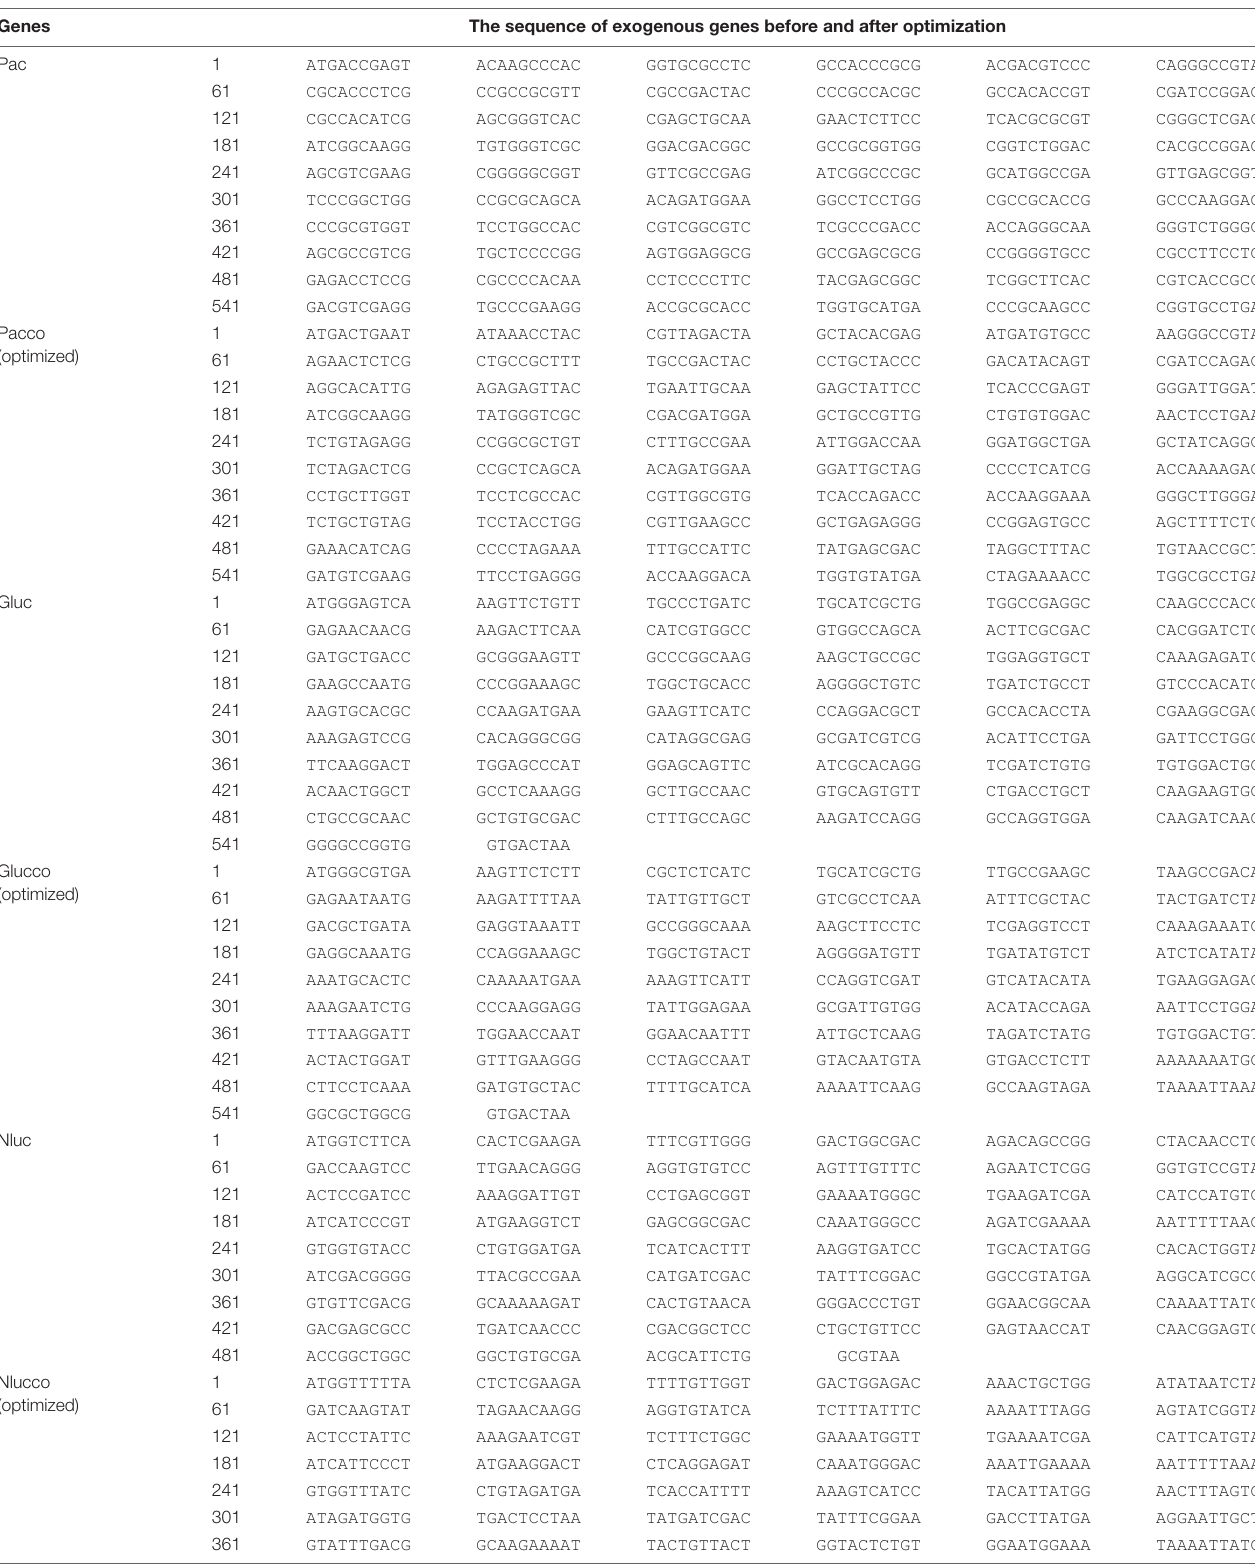
TABLE 3 | The sequence of exogenous genes before and after optimization. Genes The sequence of exogenous genes before and after